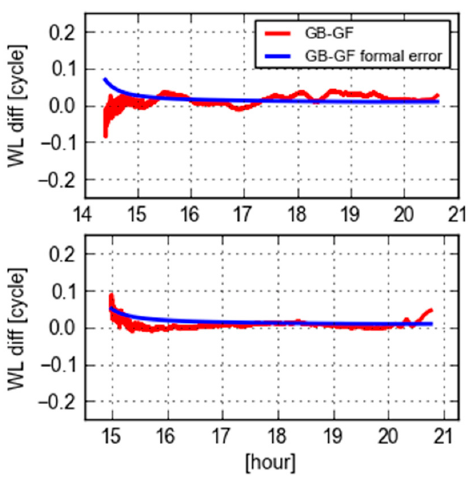
Figure 4. Differences of GB and GF WL ambiguities (red) and their formal errors (blue) of PRN 09 from the receivers CEBR ( top ) and REDU ( bottom ).